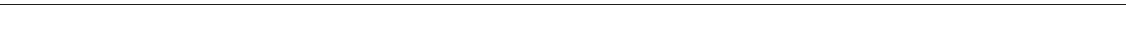
Fig. 2 Characterization of Ptf1a-reprogrammed iNSCs. a Neurospheres induced from MEFs by Ptf1a at day 8 and 10 were immunoreactive for Ptf1a, Sox2, Pax6, Nestin, or Olig2. Monolayered miNSC10 cells were also immunoreactive for Ptf1a, Sox2, Pax6, or Nestin. Cells were counterstained with nuclear DAPI. Scale bars, 80 μ m. b qRT-PCR analysis showed that in comparison with MEFs, there was a great increase in expression of Nestin , Olig2, Pax6 , and Sox2 genes in Ptf1a-derived miNSC5, miNSC10, and miNSC12 cells, as well as in control SCR029 NSCs. Data are presented as mean ± SD ( n = 4). Asterisks indicate signi fi cance in unpaired two-tailed Student ’ s t -test: * P < 0.0005. c qRT-PCR assay showed that compared with mouse ESCs, there was only minimal or no expression of pluripotent factor genes Klf4 , Nanog , and Oct4 in miNSC and control NSC cells. As a pluripotent factor gene and also NSC marker gene, Sox2 exhibited high levels of expression in both miNSC and ES cells. Data are presented as mean ± SD ( n = 4). Asterisks indicate signi fi cance in unpaired two-tailed Student ’ s t -test: * P < 0.05, ** P < 0.005, *** P < 0.0001. d As revealed by qRT-PCR assay, expression of fi broblast cell marker genes Snai1 , Twist2 , and Col1a1 was dramatically downregulated in miNSC cells. Data are presented as mean ± SD ( n = 4). Asterisks indicate signi fi cance in unpaired two-tailed Student ’ s t -test: * P < 0.0001. e DNA methylation status was examined in the promoter regions of Nestin , Oct4 , and Nanog genes. Filled and empty circles represent methylated and unmethylated CpGs, respectively. Compared with MEFs, the promoter region of Nestin became hypomethylated in SCR029 and miNSC10 cells; however, the promoter regions of Oct4 and Nanog remain